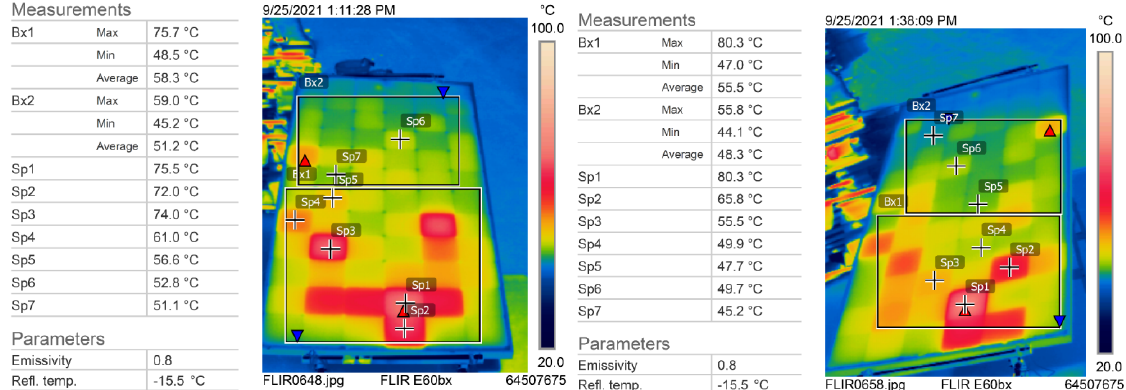
Figure 23. Thermographic analysis of module number 7 ( left ) and module number 8 ( right ). The analyzed modules showed different thermal patterns, resulting from the short- circuit current at different solar irradiance values. The recorded values corresponded to the information found in [18,20,29]. Table 12 shows the values of solar irradiance and contact measurement values of the module temperatures that preceded the thermographic test. Table 12. Solar irradiance and module temperature at the time of the measurement.